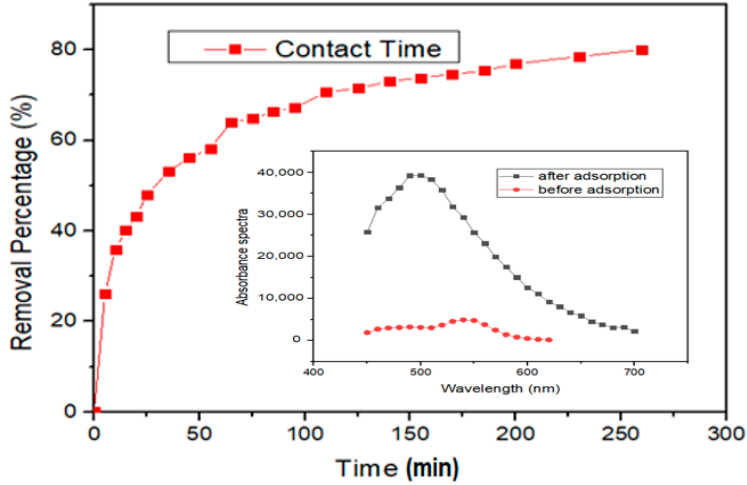
Figure 7. Effect of contact time on the removal efficiency of lead ions by CDs. Figure 7. E ff ect of contact time on the removal e ffi ciency of lead ions by